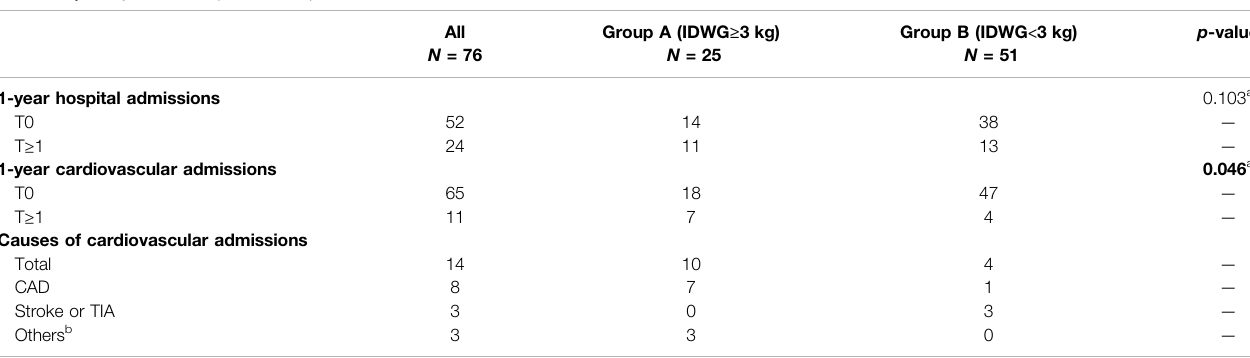
TABLE 2 | One-year follow-up of the hospital